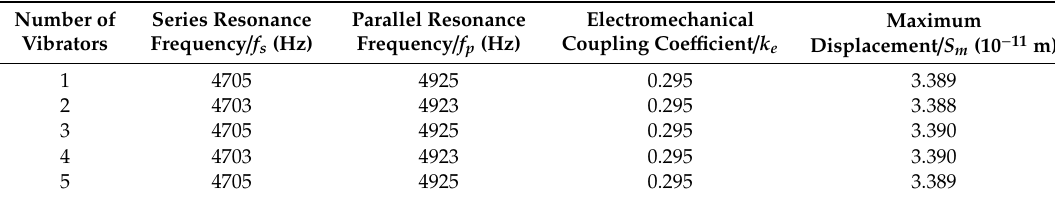
Table 4. Performance parameters of the ceramic vibrators